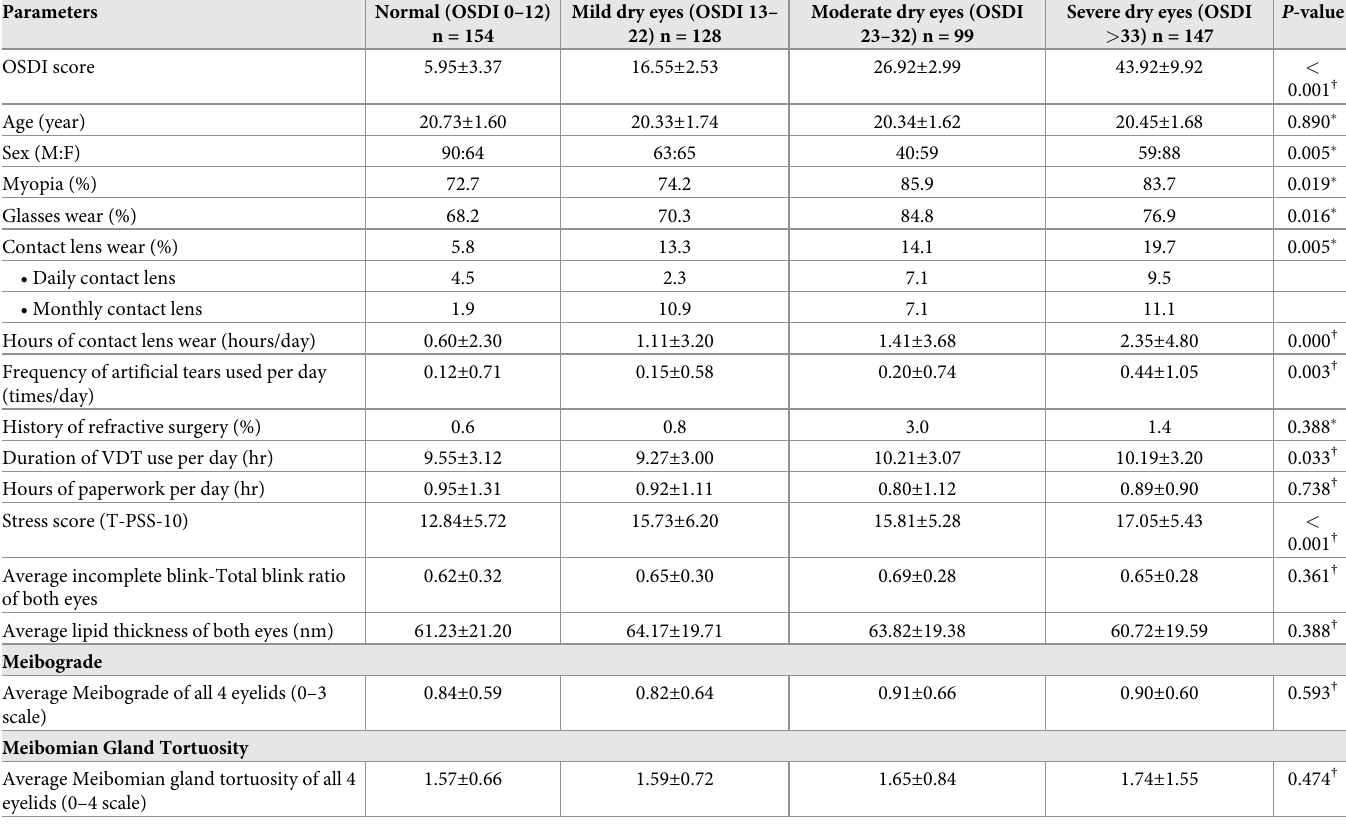
Table 2. Univariate analysis of potential risk factors according to the severity of dry eye symptoms.